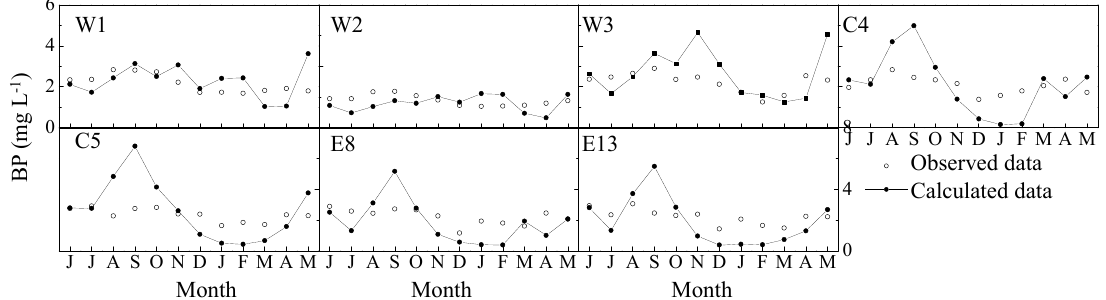
Figure 5. BP (mg L − 1 ) model (line + dots) and observed data (open dots) at 7 sites for June 2015 to May